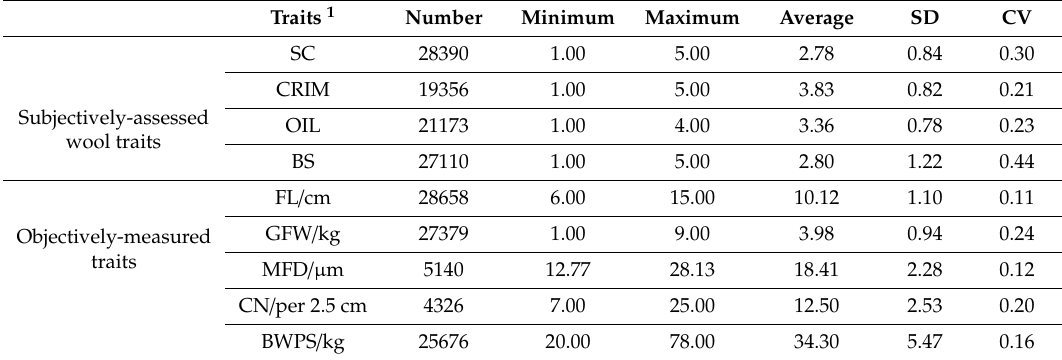
Table 2. Description of wool traits in Chinese Merino sheep (Xingjiang type).